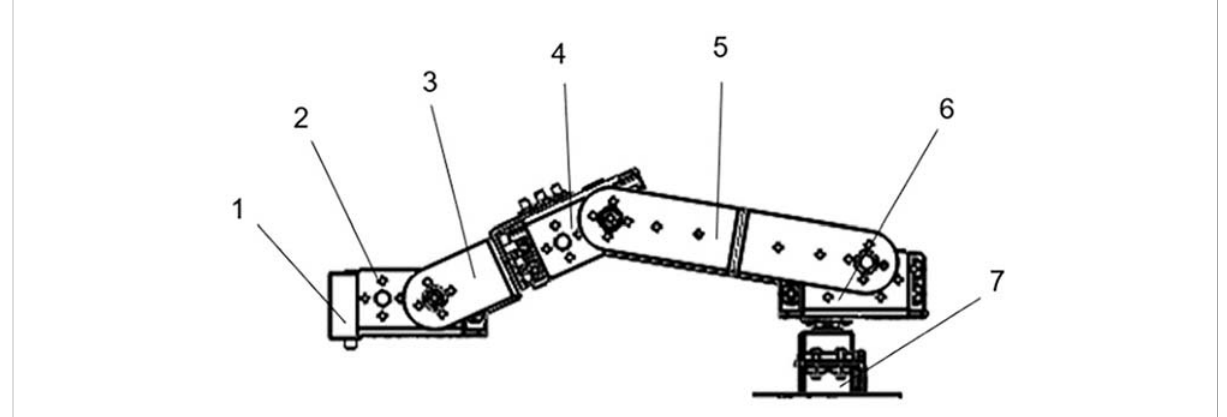
FIGURE 10 Structural design of fi ve-degree-of-freedom robotic arm. 1. Laser emitter; 2. robot arm I; 3. robot arm II; 4. robot arm III; 5. robot arm IV; 6. robot arm turntable; 7. servo